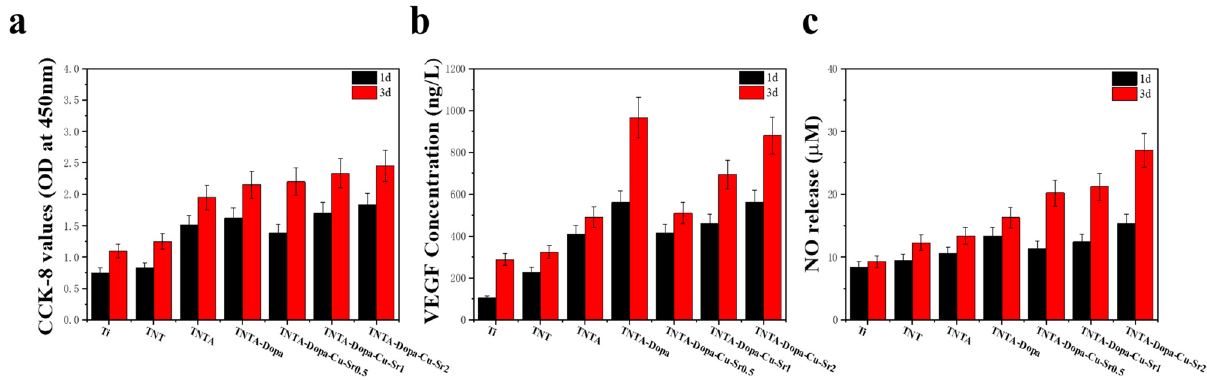
Figure 8: CCK - 8 values ( a ) , VEGF ( b ) , and NO ( c ) activities of the endothelial cells grown on the di ff erent samples surfaces for 1 and 3 days,